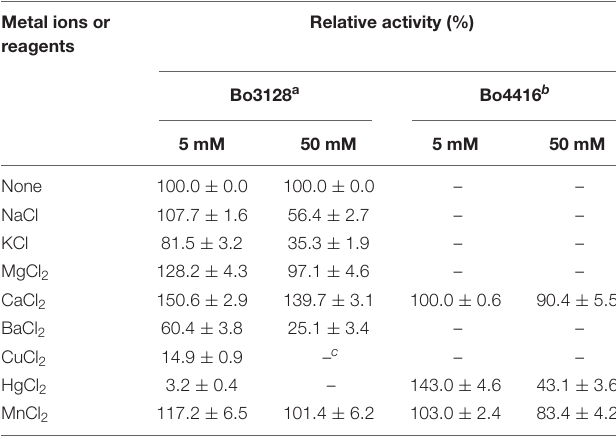
TABLE 1 | Effects of metal ions on Bo3128 and Bo4416 activities.